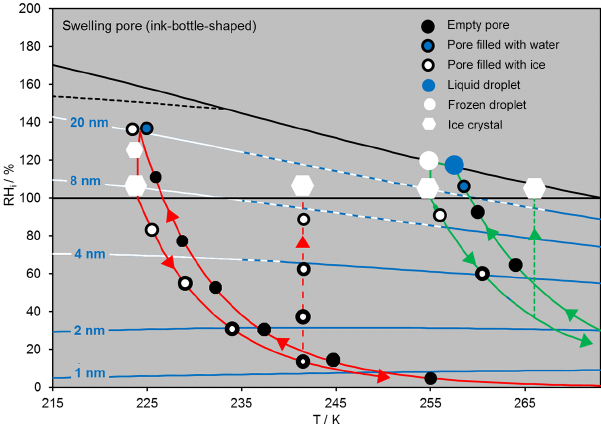
Figure 3. Wet trajectory (green line) and dry trajectory (red line) of a particle with a swelling ink-bottle-shaped pore with a cavity of 20nm and a pore opening that reacts to RH changes. Solid lines: adiabatic cooling, followed by adiabatic heating; dashed lines: in- crease in RH at constant temperature. The black horizontal line de- notes ice saturation; the black sloped line indicates RH i /T condi- tions for water saturation (parameterization of Murphy and Koop, 2005). The black dashed line gives homogeneous ice nucleation ac- cording to Koop and Zobrist (2009). The white/blue lines delimit the onset of pore filling, which were calculated using the inverse Kelvin equation (Eq. 1). Pores with diameters given on the lines are filled at RH i values above the line and are empty below the line. The white portion denotes pore ice, the blue one pore water, and the dashed portion pore water or pore ice, depending on the particle history. The limit to high temperature of the dashed portion marks pore melting. Water in pores of 2 and 1nm remains